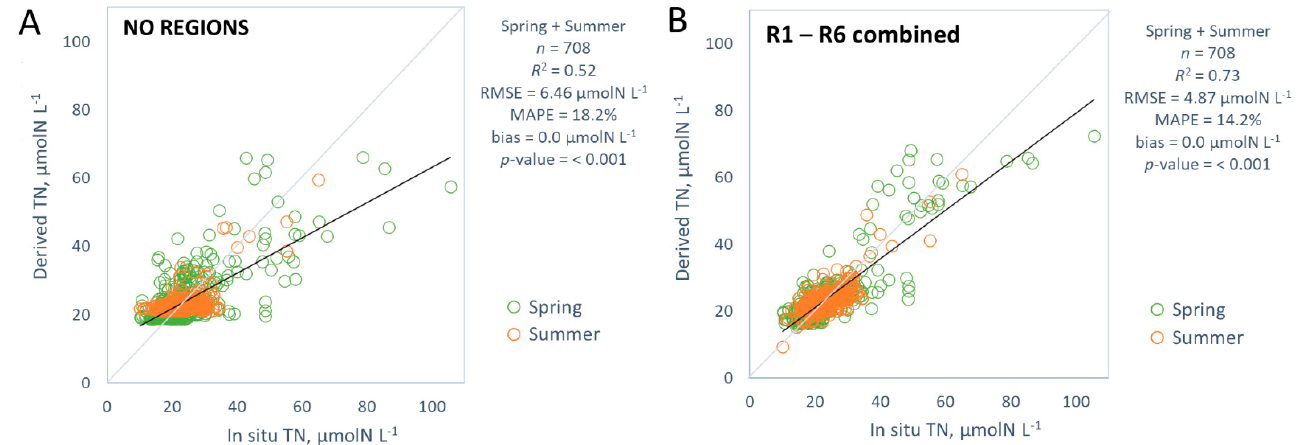
Figure 4. The comparison of the derived total nitrogen (TN, µ molN L − 1 ) with the in situ TN: ( A ) the derived TN is based on all the stations with no regions; ( B ) the TN is derived in all the regions (R1–R6) separately. The statistics on the right and the linear regression trendline (black line) are combined periods of spring (April to June: green rings) and summer (July to September: orange rings). There were significant differences in deriving TN in different regions. The strongest relationship with TN was in region R2 (Pärnu Bay) ( R 2 = 0.74), while the weakest relation- ship was in regions R3 and R6 ( R 2 = 0.17 and 0.15, respectively) (Figure 5). The RMSE was between 3.11 to 8.85 µ molN L − 1 (regions R4 to R2, respectively). Although the region R2 had the strongest relationship towards TN, the accuracy was the lowest (81.4%), because the absolute values of TN were at least twice as high compared with other regions. In region R2, the TN max is 105.6 µ molN L − 1 , while in other regions, the TN max ranges from 29.8 µ molN L − 1 to 48.6 µ molN L − 1